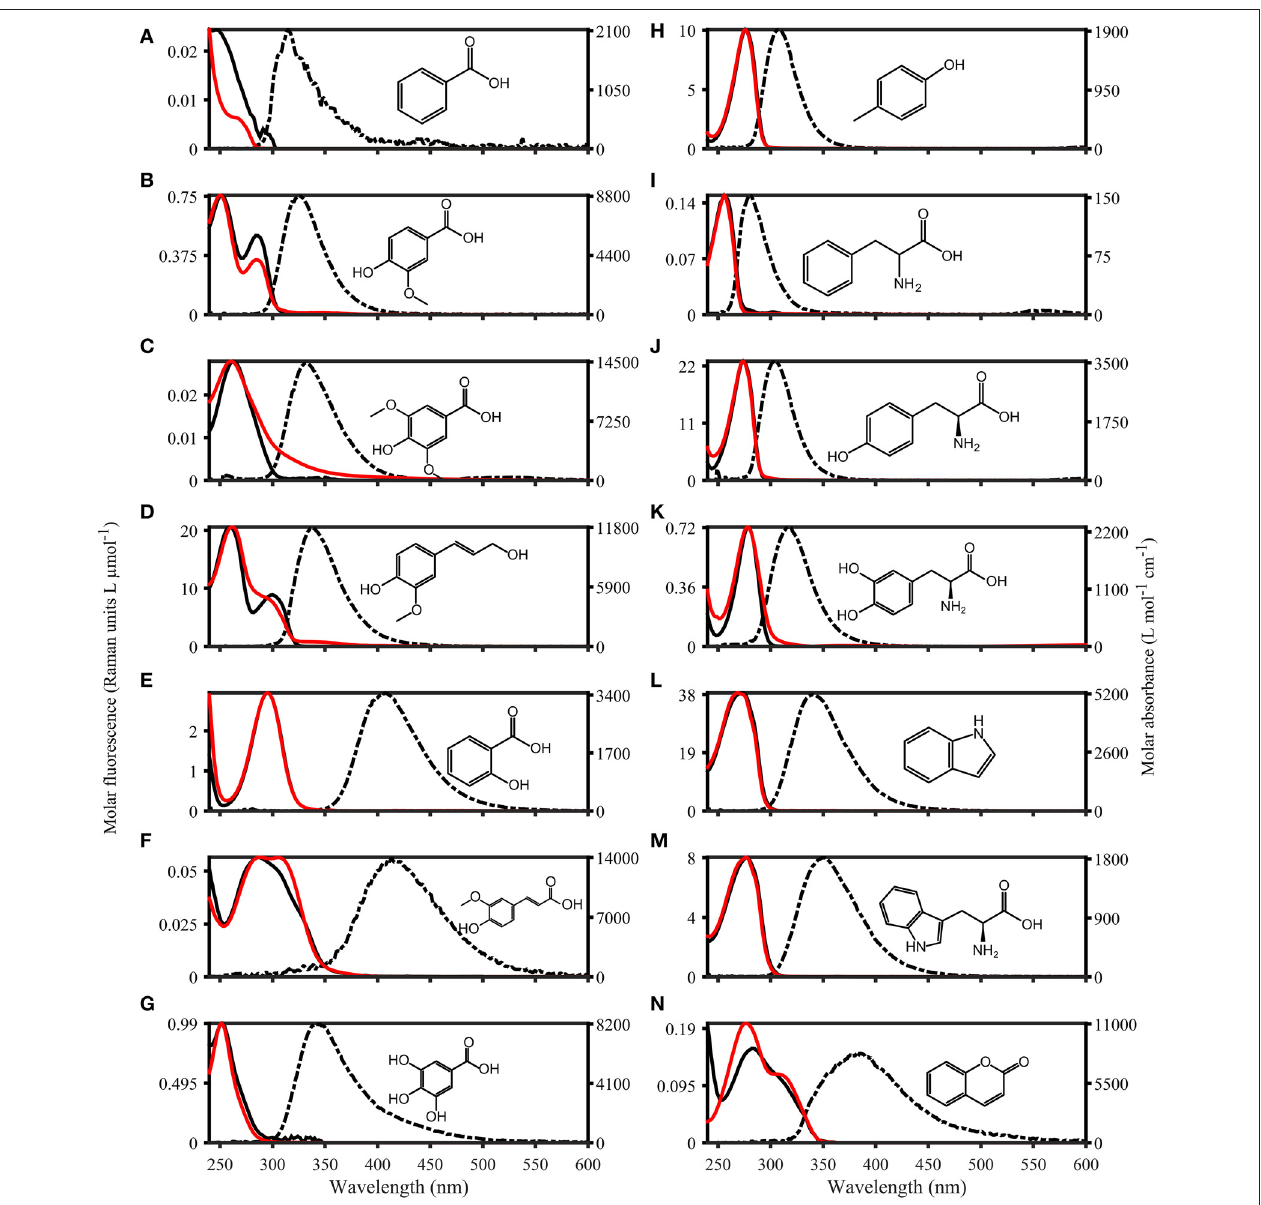
FIGURE 3 | Absorbance and Fluorescence spectra of organic compounds dissolved in water with 1mmol L − 1 PO 4 buffer (pH 7.5). The molar absorptivity is shown as a solid red line, excitation loadings are solid black lines, and emission loadings are dashed black lines. (A–G) Benzoic acid, vanillic acid, syringic acid, coniferyl alcohol, salicylic acid, ferulic acid, gallic acid. (H–N) p-Cresol, phenylalanine, tyrosine, dihydroxyphenylalanine, indole, tryptophan,